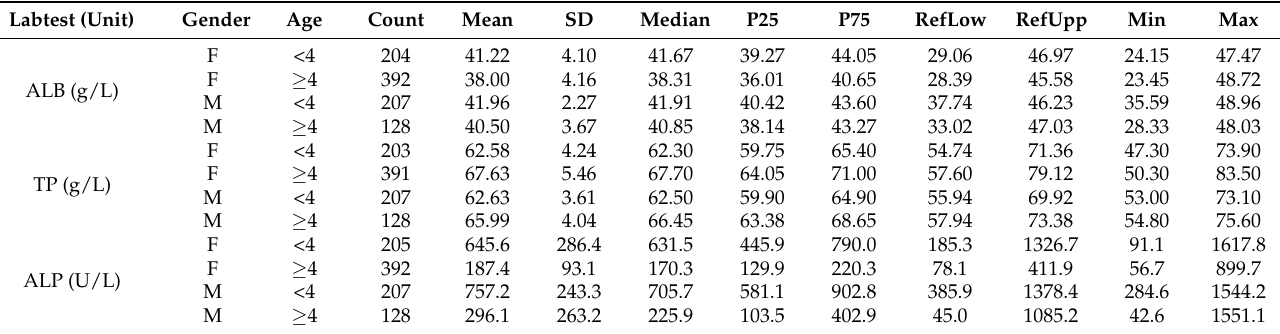
Table 5. Serum biochemical reference intervals and percentiles in the cynomolgus macaques exclud- ing